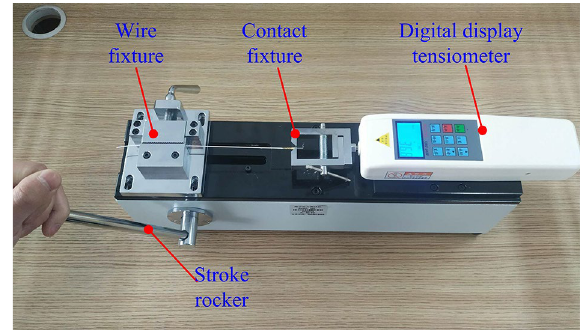
Figure 3. Test experiment on tensile strength of crimping